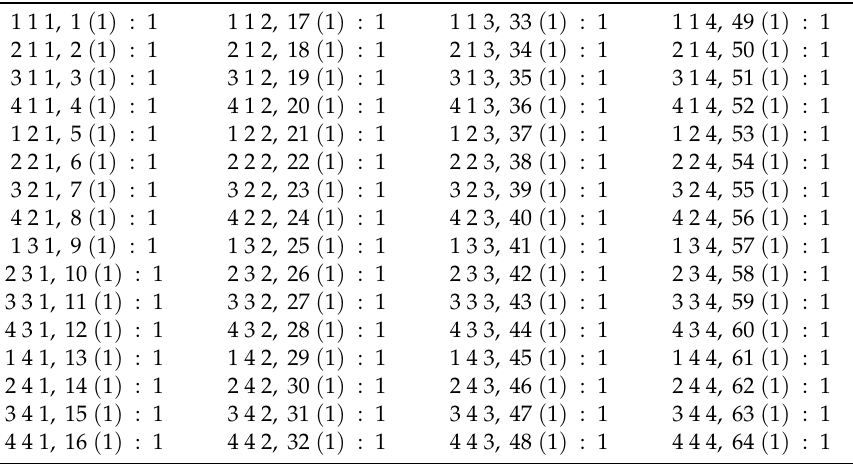
Figure 4. Fuzzy inference system employed. Table 3. Codification of the rules.